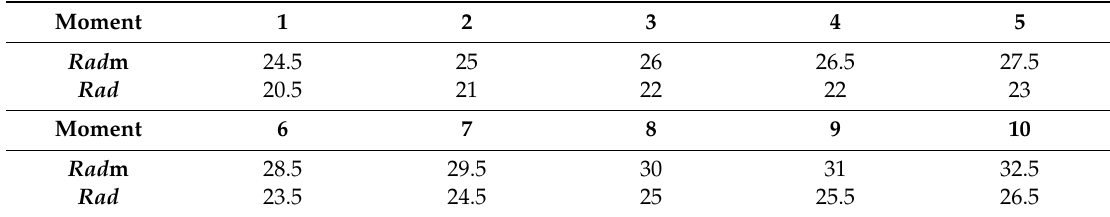
Table 6. The danger sector after changing Ship 1’s manoeuvrability in a crossing